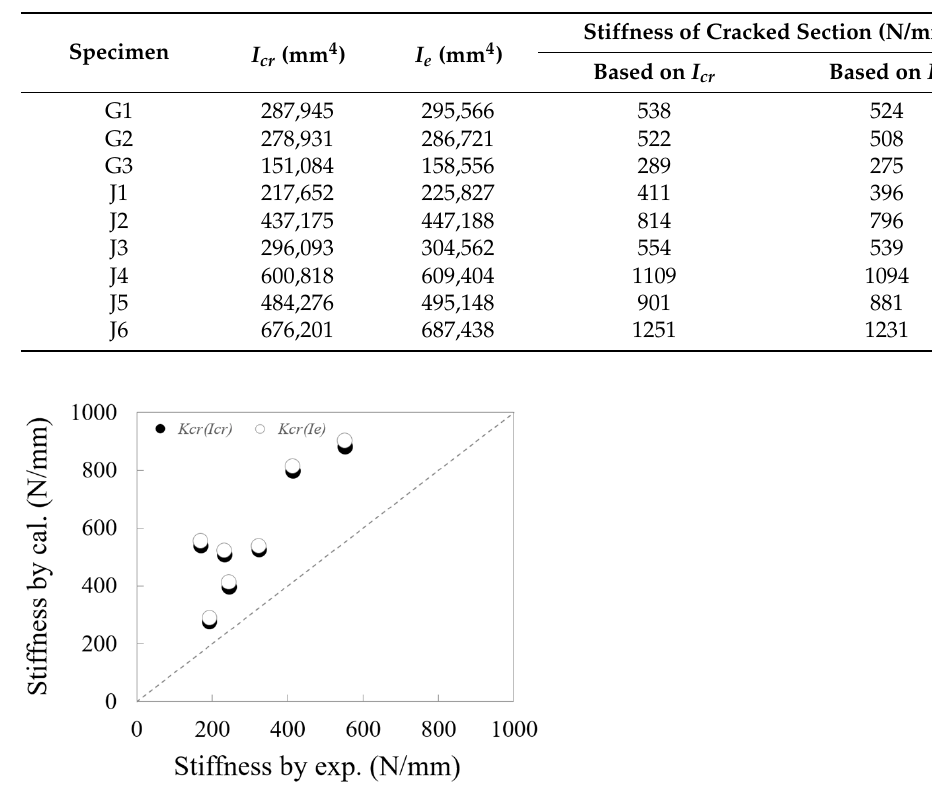
Table 9. Stiffness of cracked sections by effective and cracked transformed moment of inertia.